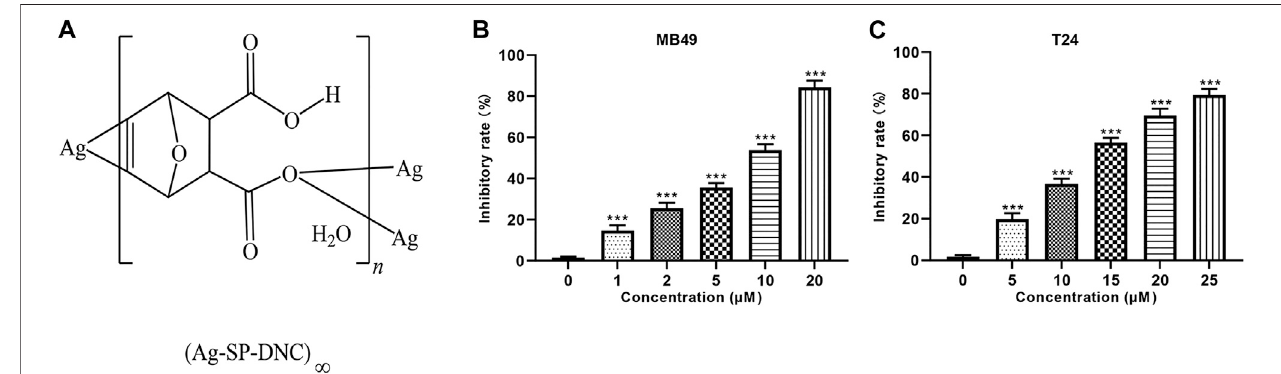
FIGURE 1 | Ag-SP-DNC shows potent growth inhibition in bladder cancer cells in vitro . (A) Chemical structure of Ag-SP-DNC. (B) Inhibitory rate histogram of MB49 treated with Ag-SP-DNC for 48 h. Data are mean ± SEM; n (cid:1) 3. *** p < 0.001. (C) Inhibitory rate histogram of T24 treated with Ag-SP-DNC for 48 h. Data are mean ± SEM; n (cid:1) 3. *** p <